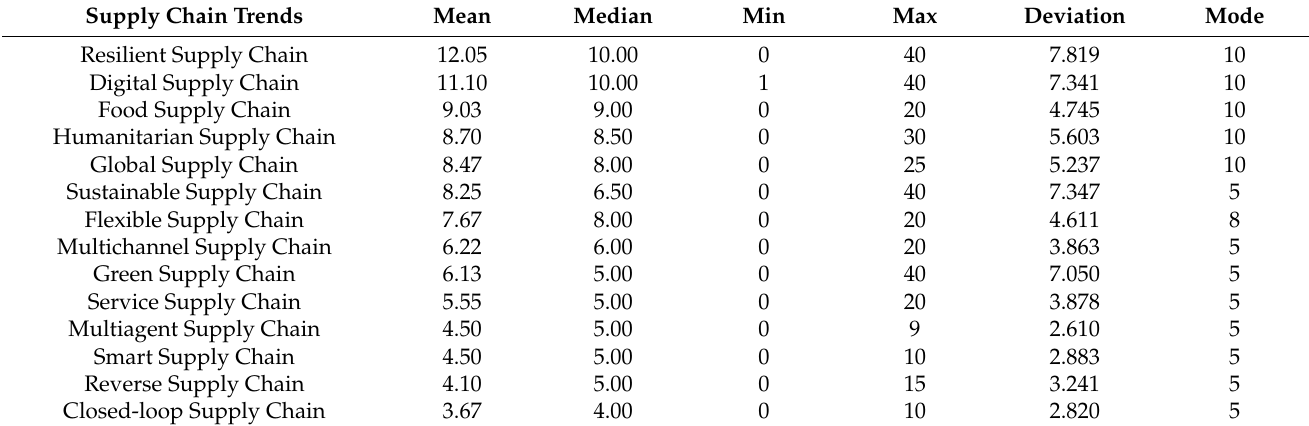
Table 4. Final results of opinions about global theoretical trends and supply chain development directions in the context of dynamic global changes related to the COVID-19 pandemic, according to the experts’ assessments 1–30; own elabora- tion based on the conducted research.